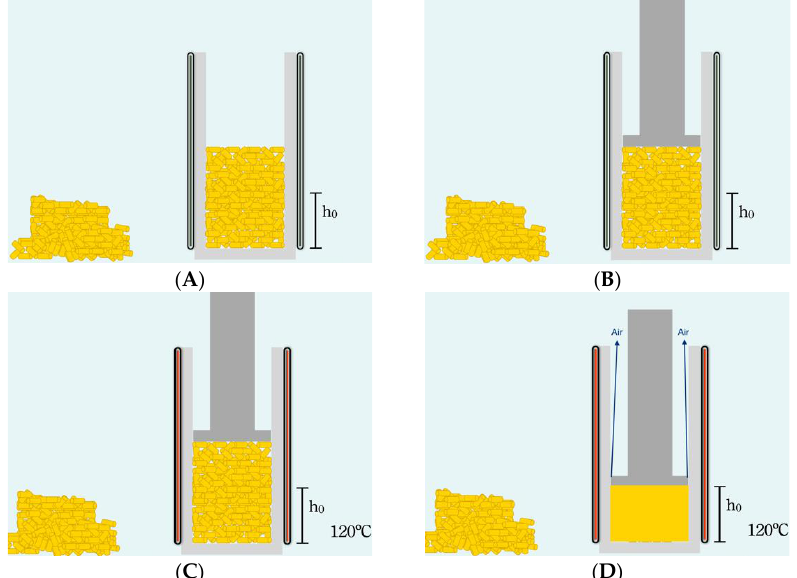
Figure 1. Schematics of the fabrication of the foam precursor. ( A ) Insert the pellets into the mold, ( B ) Close it with a piston, because the piston is loose, and the air could escape. ( C ) Heat at 120 ◦ C to melt the polymer at 5 Tn and obtain a cylinder without trapped air. ( D ) We check all precursors by mass and density to be sure there is no air trapped in them. The density of the precursors ranged from 925 kg/m 3 to 957 kg/m 3 , depending on the amount of azodicarbonamide in the